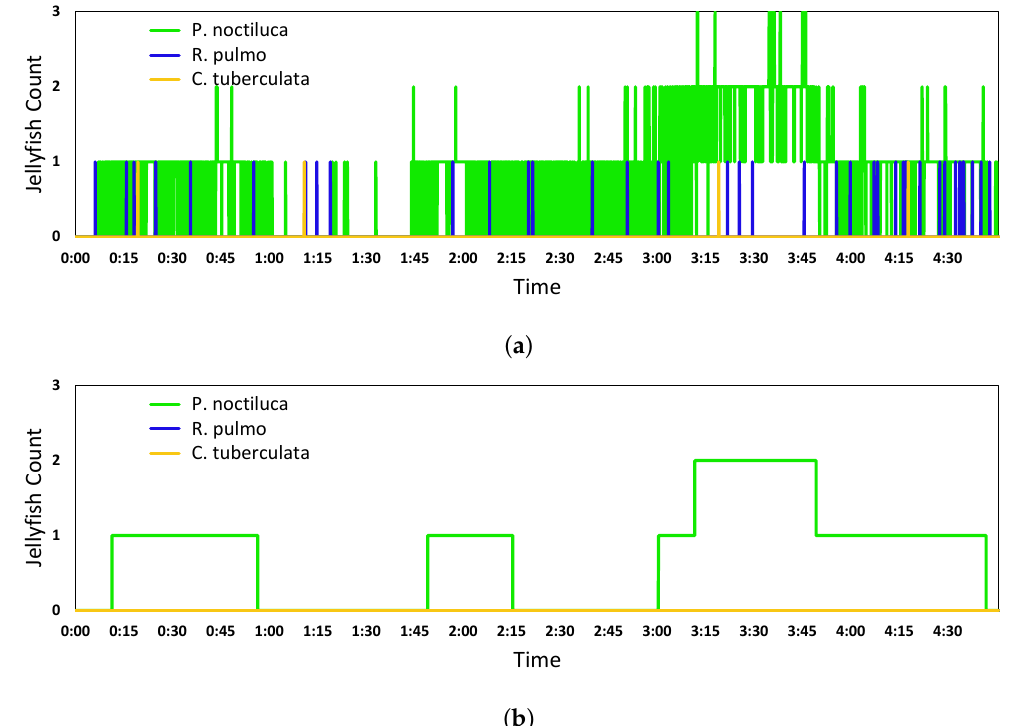
Figure 12. Results of the jellyfish count from the Inception V2 network final predictions ( a ) and quantification algorithm ( b